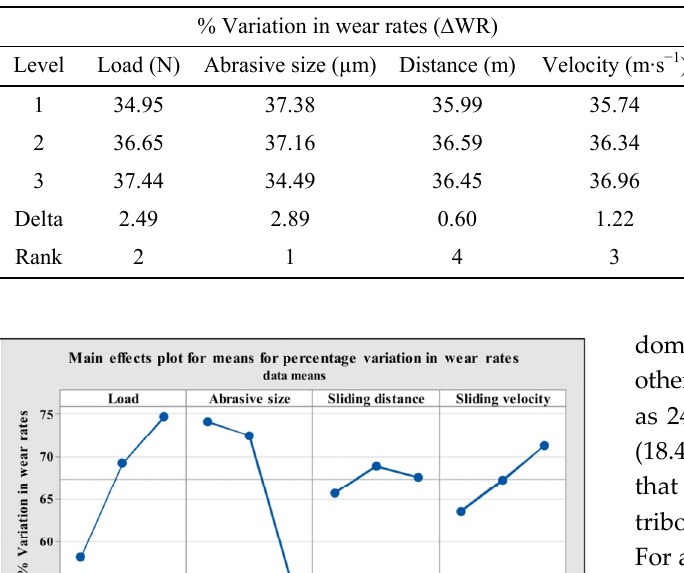
Table 4 Response tables for S/N ratios (larger is